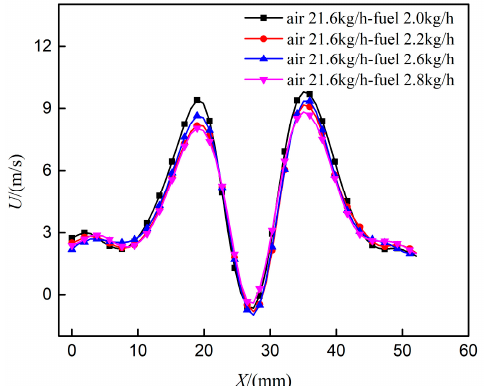
Figure 17. The influence of fuel mass rate on the axial velocity ( U ) at a distance of 20 mm from the swirler exit in the y -direction (Case B).